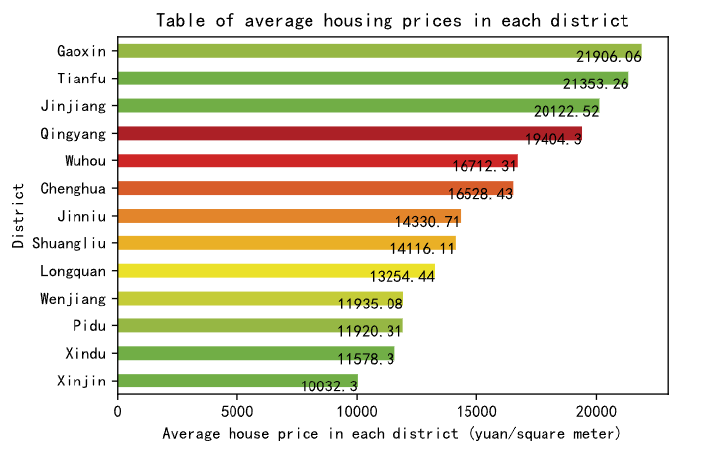
Fig. 2 Average price of houses in various regions